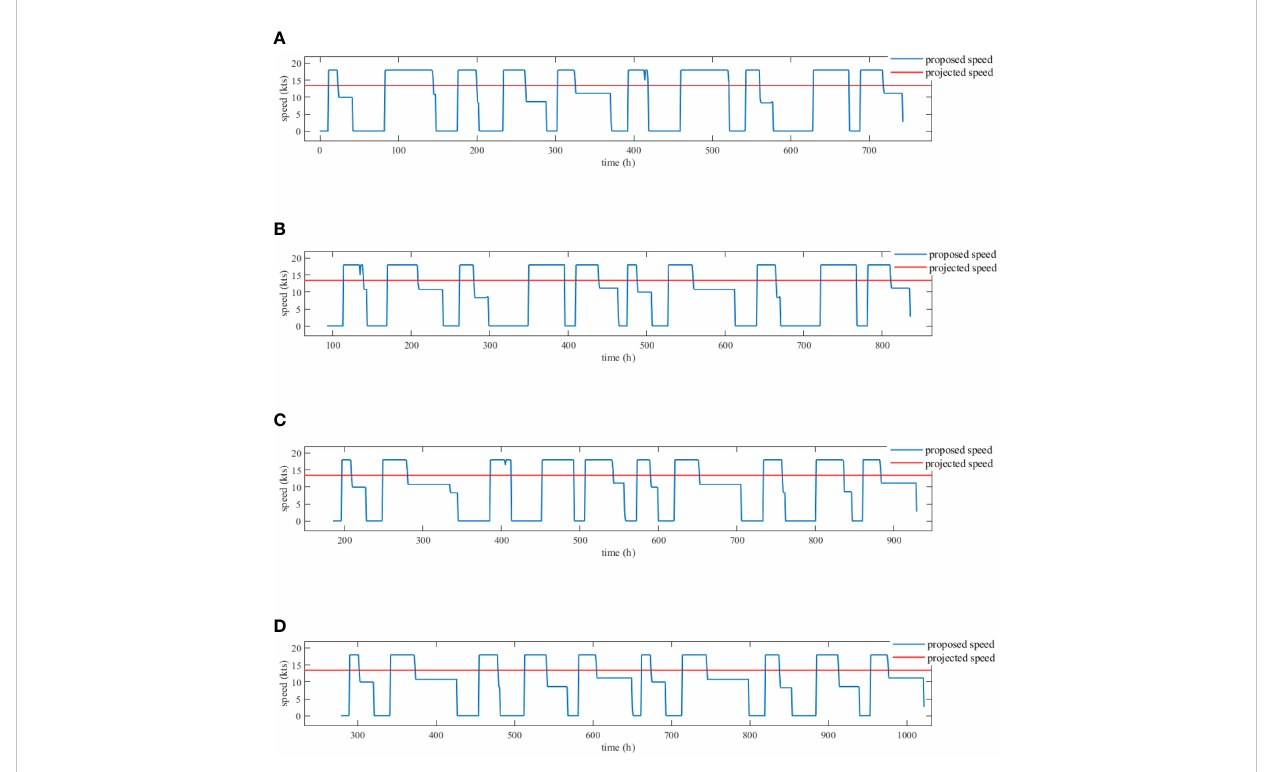
FIGURE 8 Speed of each ship under Reference 1: (A) ship 1; (B) ship 2; (C) ship 3; (D) ship 4.